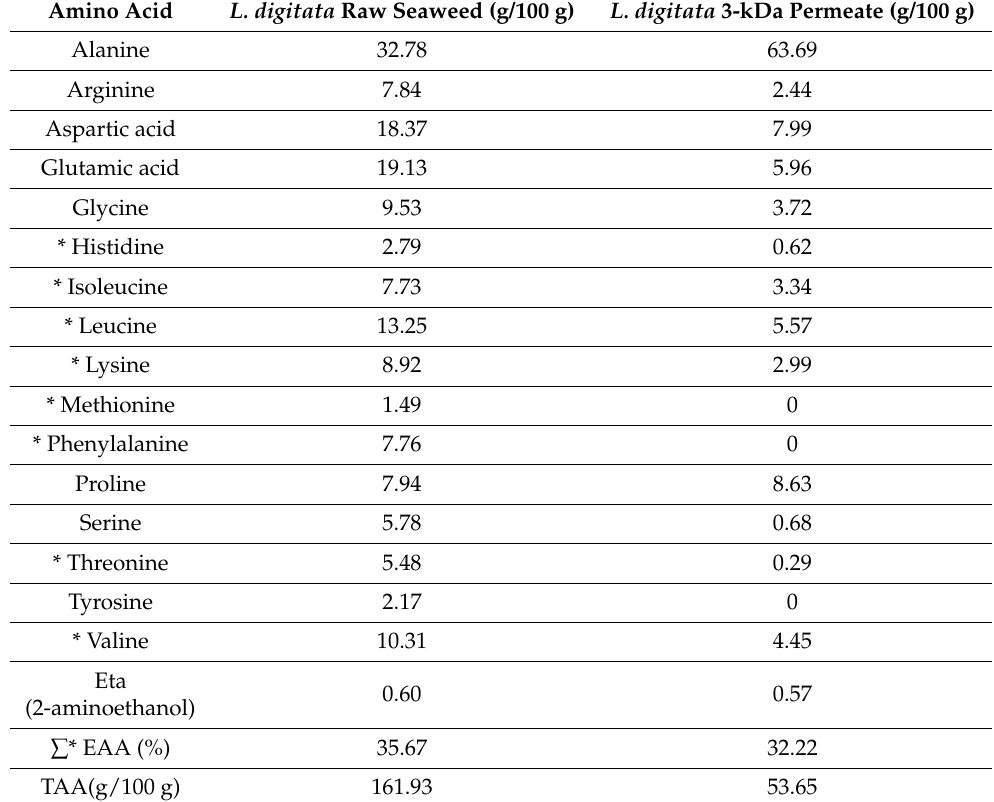
Table 2. Total amino acids content of untreated L. digitata and L. digitata 3-kDa permeate fraction recovered following MWCO